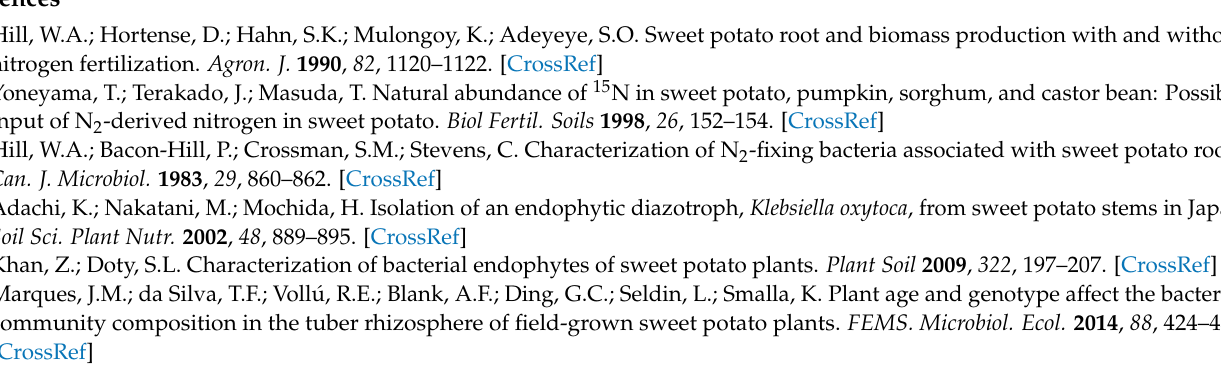
Table S2: Quantification of phytohormones in bacterial cells or culture medium by LC/MS/MS. Figure S2: O 2 levels across roots of sweet potato